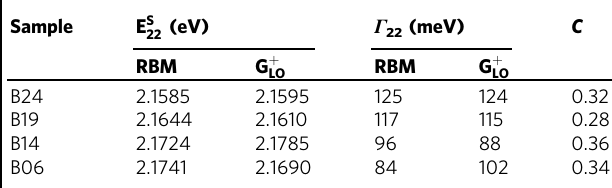
Table 1 Fit parameters for the (6,5) RBM and G þ